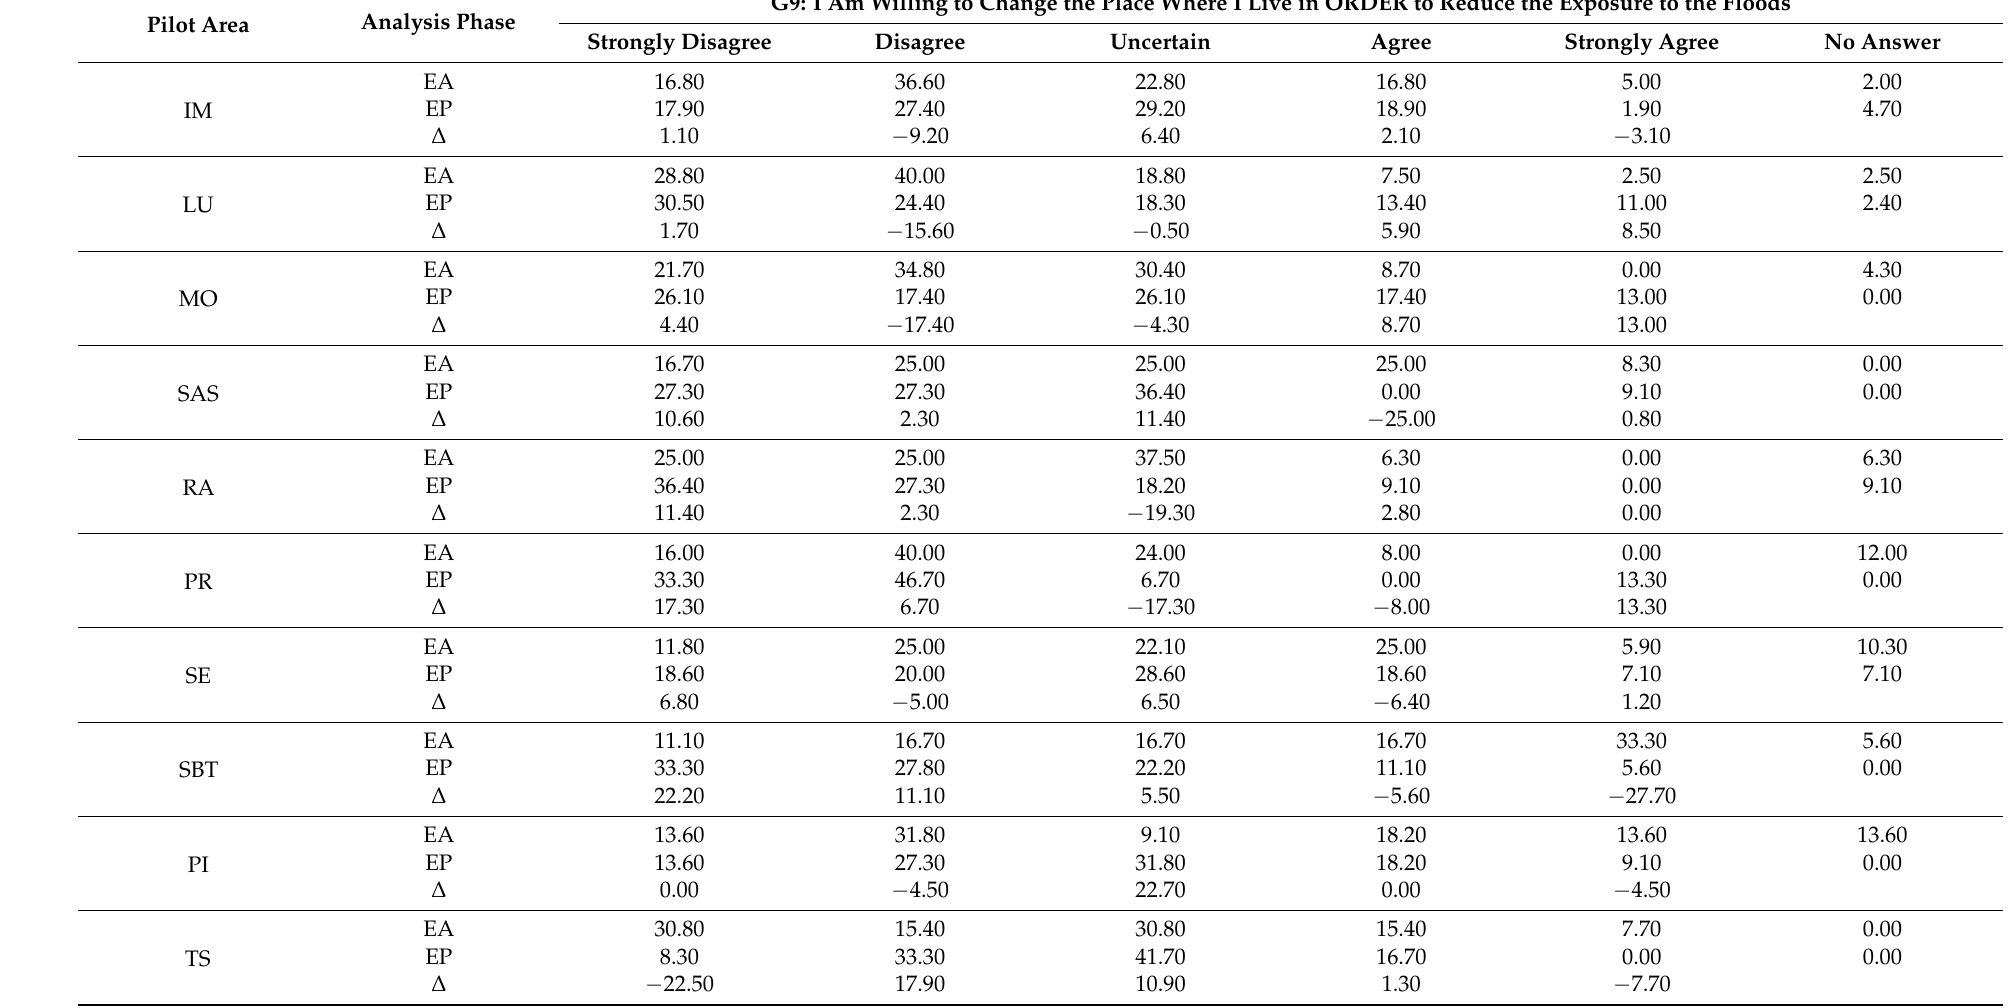
Table A10. Answers to the question G9 in percentages per each pilot area, in the ex-ante (EA) and in the ex-post (EP) phases, and their variation ( ∆